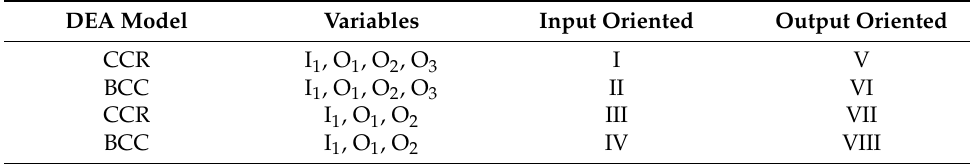
Table 7. Modifications of the DEA model for NPO/NGO.